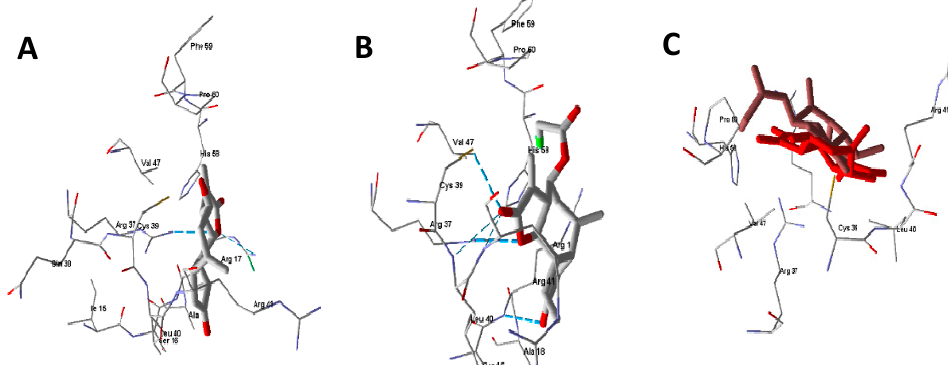
Figure 6. Docking poses of grosheimin ( 3 ) and chloroacetate grosheimin ( 3a ) in the ZAP-70 SH2 module. Panel ( A ). Docking pose of grosheimin ( 3 ). Panel ( B ). Docking pose of chloroacetate grosheimin ( 3a ). Panel ( C ). Superimposed docking poses of the grosheimin ( 3 ; red) and chloroacetate grosheimin ( 3a ; brown). In each panel, residues within 4 Å of the pose are shown. H-bonds are shown as blue dashes.